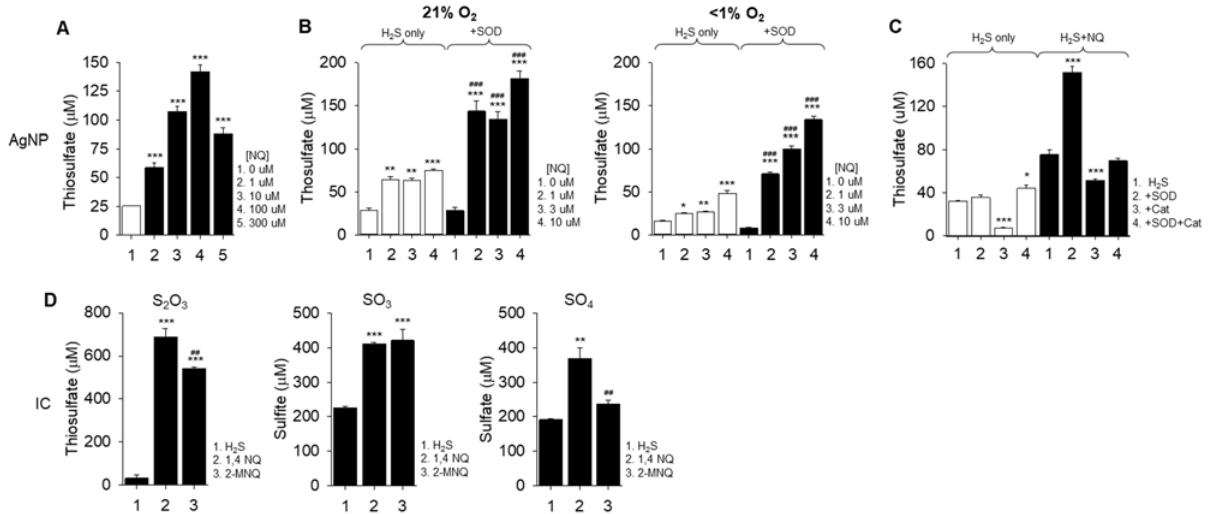
Figure 4. Effects of various parameters on thiosulfate (TS) production from 1,4 ‐ NQ (NQ) oxidation of 300 μ M H 2 S measured with silver nanoparticles ( A – C ) or by ion chromatography ( D ). ( A ) NQ concentration ‐ dependently increased TS production from 1 to 100 μ M and decreased it at 300 μ M.